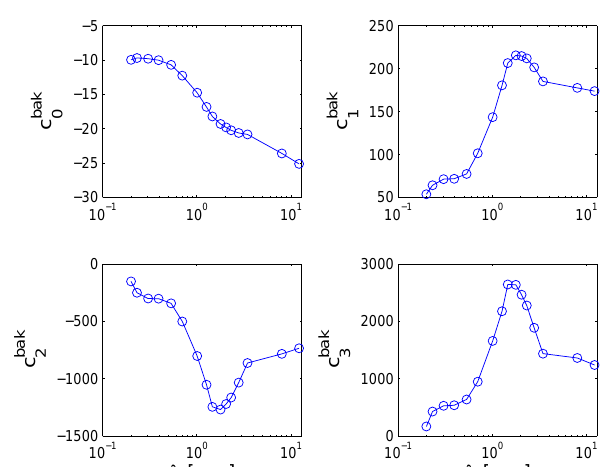
extinction coefficient (upper right), ω (lower left), and g (lower right). The optical parameters are shown for a wave- length of 533.2 nm. The geographic distribution of the ex- tinction coefficient correlates well with that of the PM 10 mass mixing ratios. High extinction coefficients are obtained over the ocean, where the aerosol mass is dominated by sea salt.